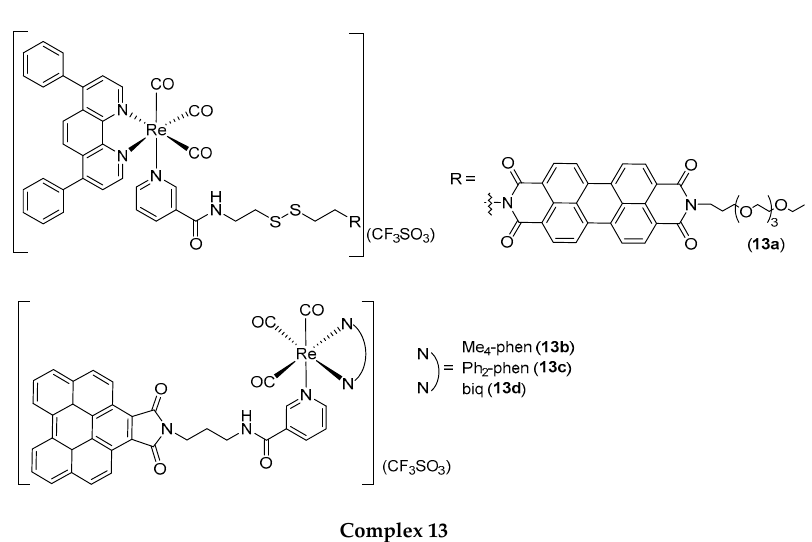
Figure 5. A number of different ligands complexed to the Re(I) tricarbonyl core forming different Re(I) tricarbonyl complexes with different photo-absorption profiles.